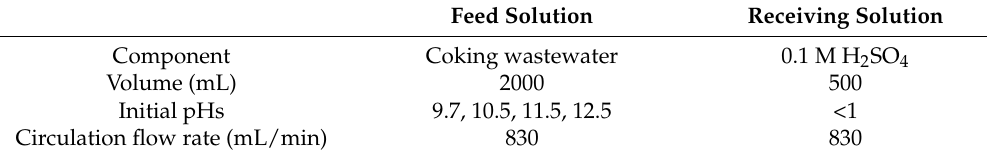
Table 3. Experimental parameters of the PTFE HFMC modules that varied the feed pH.